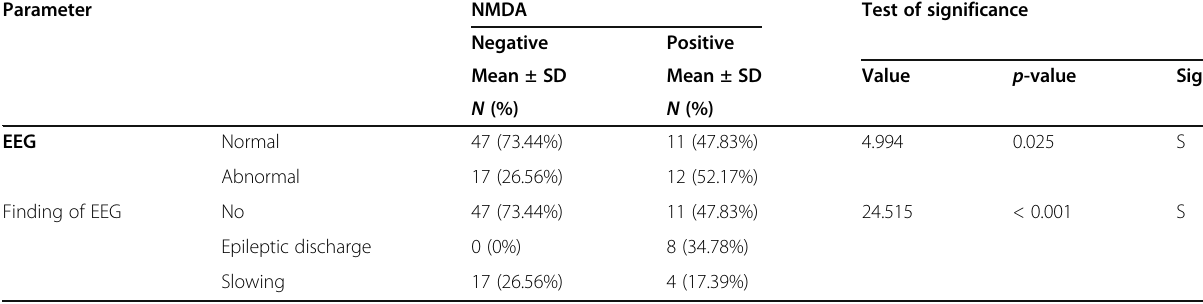
Table 4 Statistical correlation of anti-NMDAR antibody with EEG findings in the patient group of the study